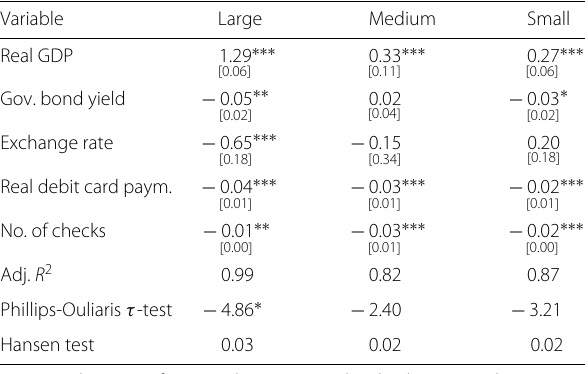
Table 1 Long-run relations based on cointegrating regression (DOLS) for groups of banknote denominations Variable Large